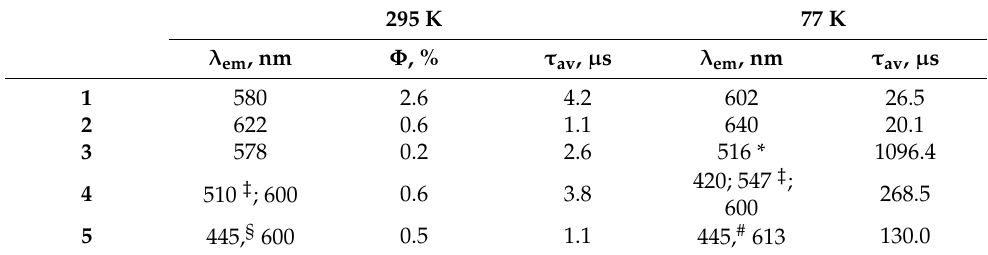
Table 2. Photophysical properties of 1 − 5 in solid state, λ exct = 351 nm.